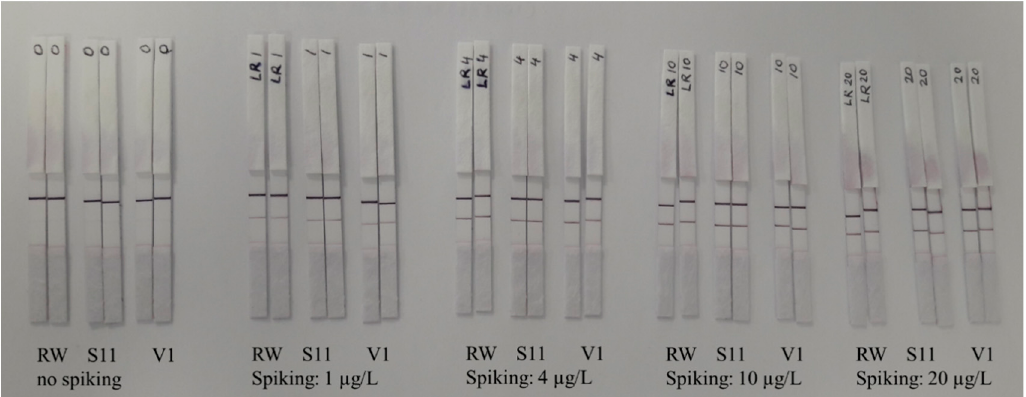
Figure 2. LFIA detection of microcystin-LR with concentrations ranging between 1–20 µg/L from spiked water samples. RW = Reagent water; S11= Alasenjärvi water; V1 = Rusutjärvi water.